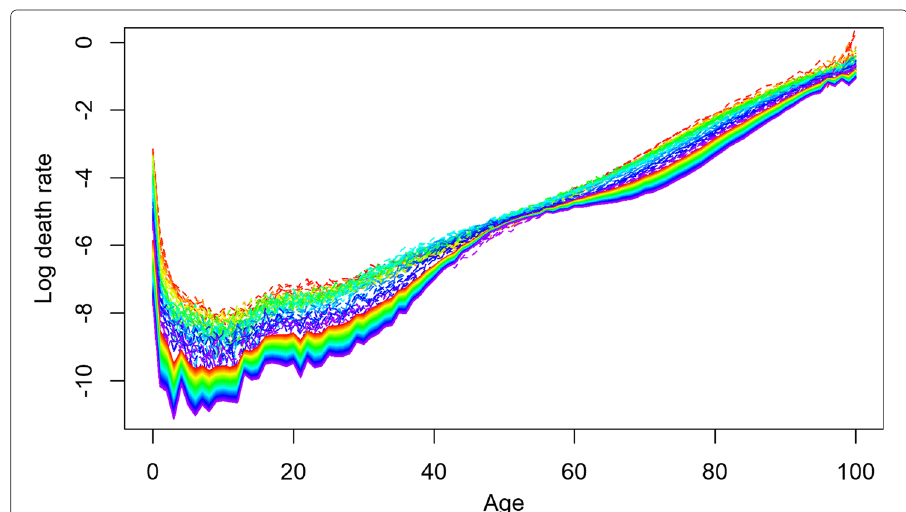
Fig. 5 Observed (1960:2014) and 40 years ahead forecast (2015:2054) of log mortality rates for females of Hungary by basic LC method. Years are plotted using a rainbow palette as before. Observed mortality rates are plotted using dotted line whereas forecast are plotted with regular line. Due to mortality improvement, the forecasts of mortality rates are below the observed mortality curves and more close to each